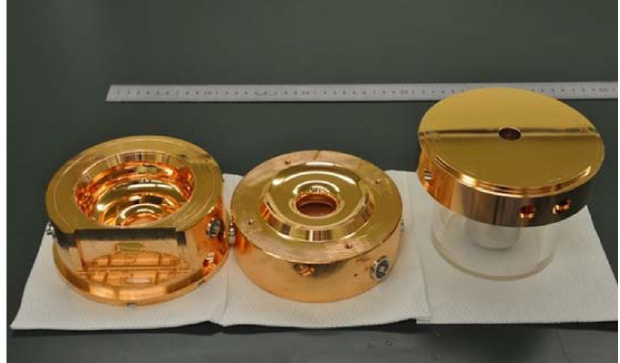
FIG. 4. The rf photocathode gun structure before brazing. Some part of the machined full cell is seen in the center and the other remaining part is in the cavity next to it, at the left in the photograph. The full cell is formed out of this asymmetric cut by